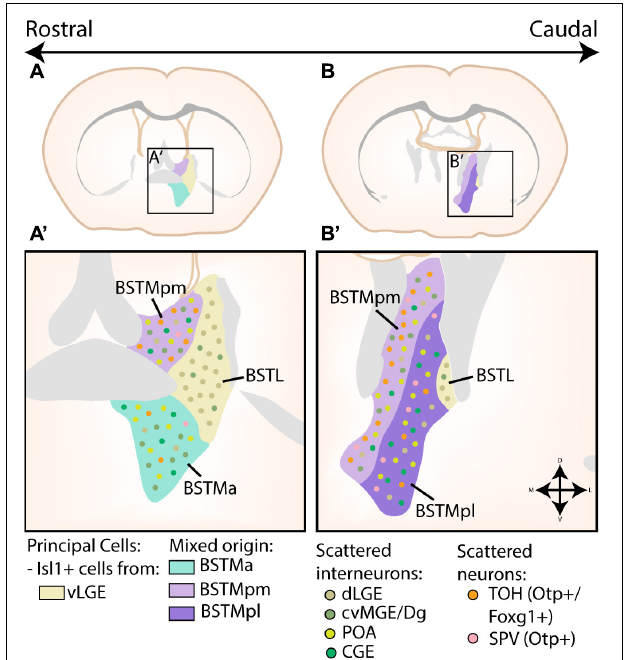
FIGURE 5 | Developmental origin of the Bed Nucleus of the Stria Terminalis. (A,A’) At rostral levels, the medial part of the bed nucleus of the stria terminalis (BSTM) contains a posteromedial (BSTMpm) and anterior (BSTMa) part. The entire BSTM contains inhibitory neurons derived from the caudoventral MGE or Diagonal area (cvMGE/Dg), CGE and preoptic area (POA). In addition, the BSTMpm contains a majority of telencephalon-opto-hypothalamic domain (TOH)-derived cells, although some cells originating from other supraopto-paraventricular (SPV) domains are also present. A small minority of TOH/SPV cells can also be found in the BSTMa. The lateral part of the bed nucleus of the stria terminalis (BSTL) is also visible at this level. The principal cells of this subnucleus are Isl1+ cells originating in the ventral LGE (vLGE), which are joined by some Pax6+ cells from the dLGE. Some of these Pax6+ cells were also found to invade the BSTM, while a minority of cvMGE-derived cells from the BSTM also inhabit the BSTL. (B,B’) At more caudal levels, the BSTM is divided into a posteromedial (BSTMpm) and posterolateral (BSTMpl) part. Here, the BSTMpm again contains the majority of TOH/SPV-derived cells, especially in its medial part, although the BSTMpl also contains scattered TOH/SPV-derived cells. The distribution of cvMGE/CGE/POA/dLGE/vLGE-derived cells in both the BSTM and BSTL remain similar to those at more rostral levels. Panels (A,B) are based on images from the Allen Brain Atlas, with the different subnuclei of the BST translated to extended amygdala terms via the scheme of Dong et al. (2001) and Allen Institute For Brain Science